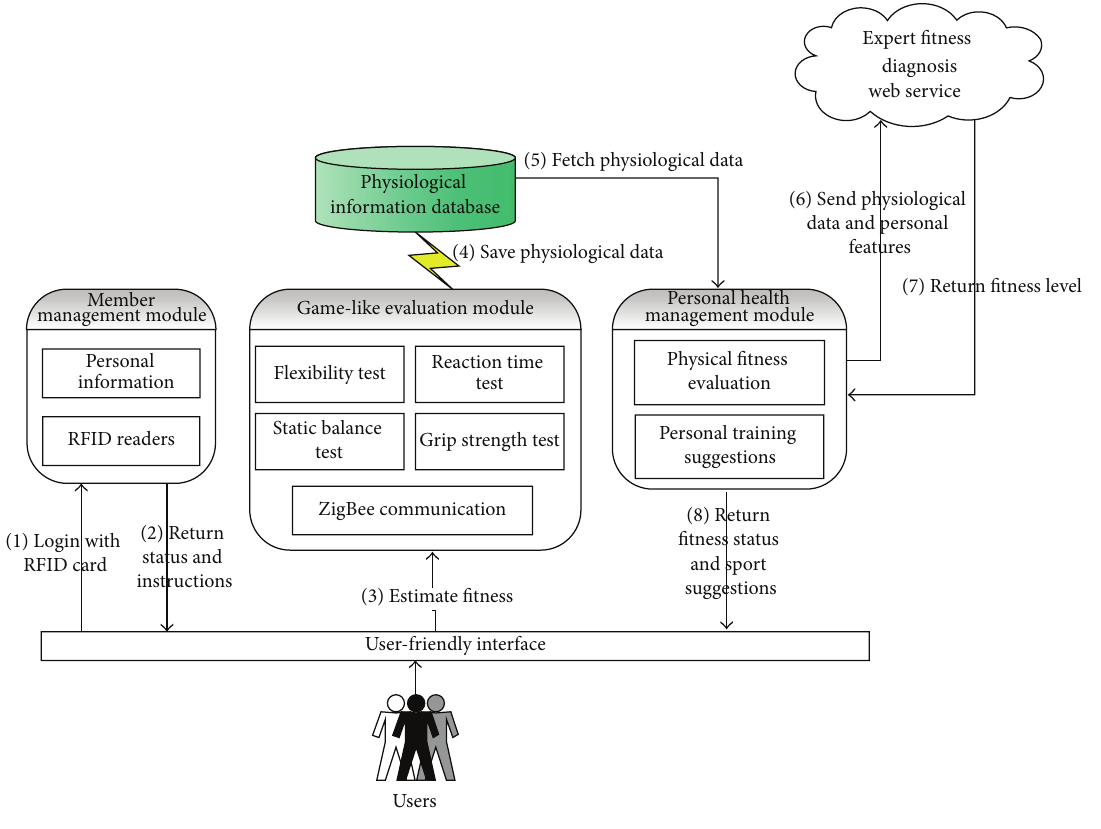
Figure 3: The system architecture of iFit.